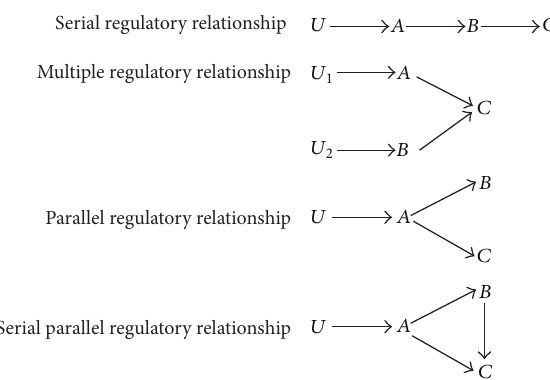
Figure 2: Possible gene regulatory relationships within a three- gene module. The three genes within a MANI module are labeled 𝐴 , 𝐵 , and 𝐶 . The arrows between genes indicate the directions of regulation tested between the genes. External inputs regulating expression of genes are given as 𝑈 , 𝑈 1 , or 𝑈 2